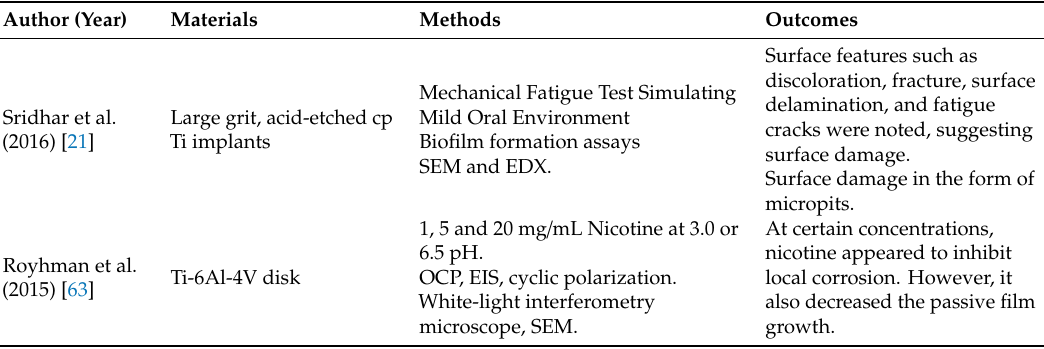
Table 1. Summary of experimental works that evaluate titanium corrosion on simulated